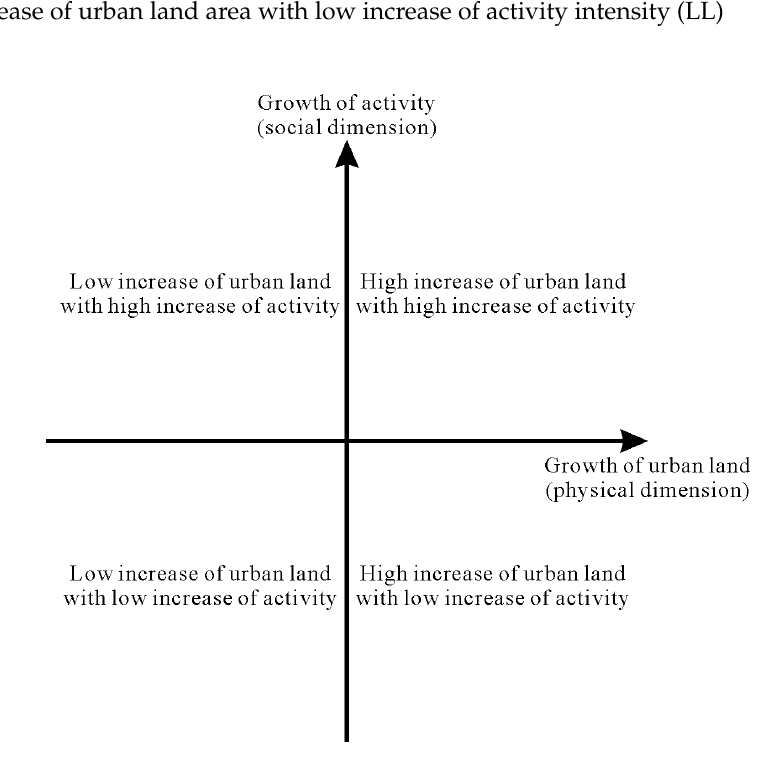
Figure 1. The four quadrants corresponding to the four possible urban growth types.